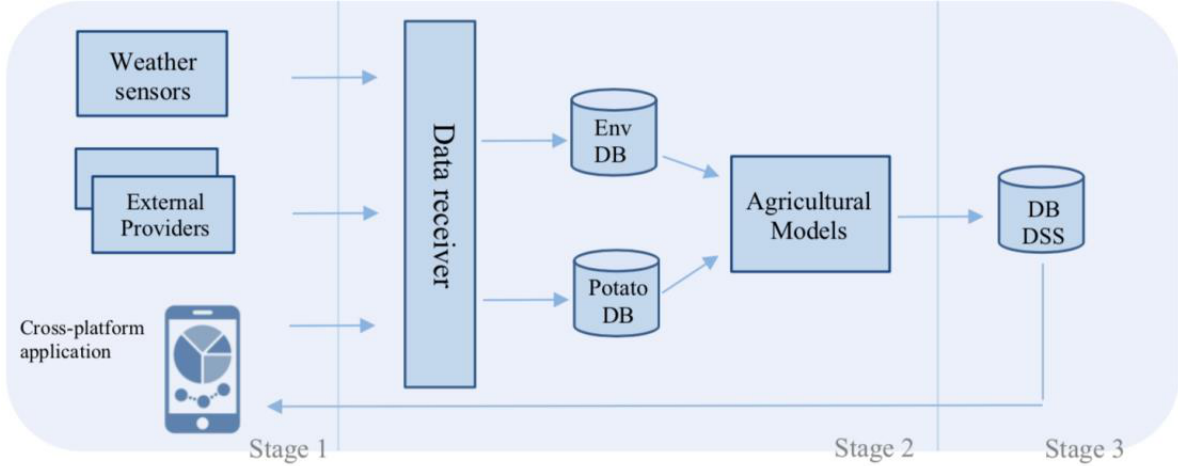
Figure 1. Conceptual diagram of the